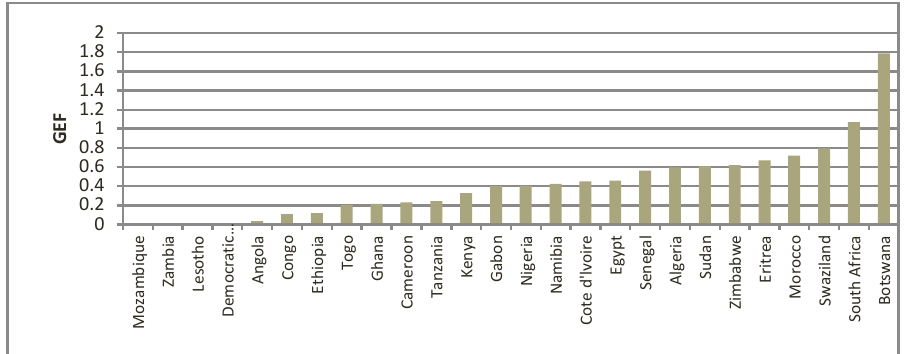
FIGURE 1: Average Grid emission factors of African countries (2008)